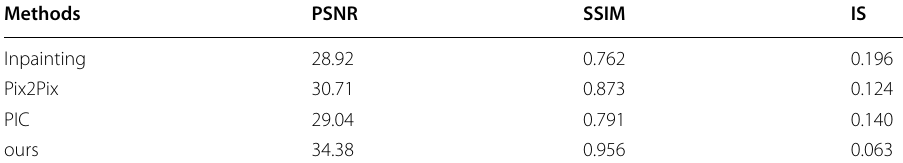
Table 3 PSNR, SSIM and inception scores (IS) on 128 random test images from CelebA Methods